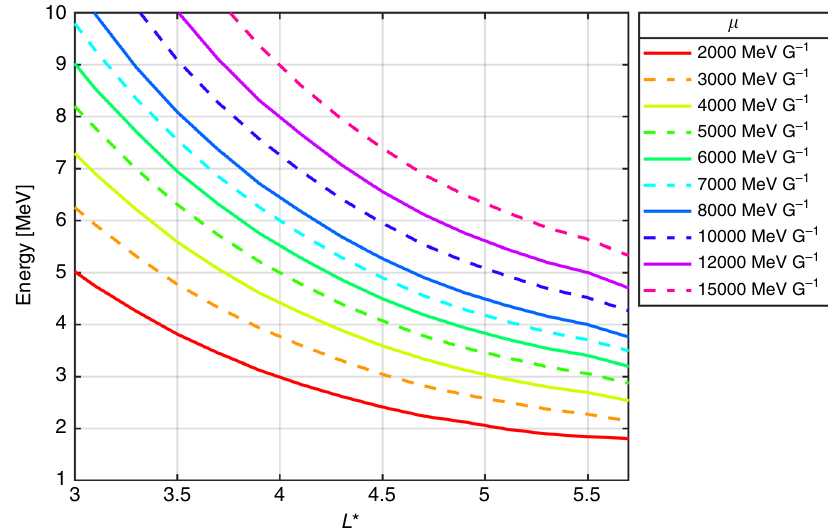
Fig. 2 The average electron energy, across L *, for various values of μ . Average energies corresponding to μ values between 2000 and 15,000 MeV G − 1 , for the 6 – 20 October 2012 period are shown. For all values of μ , K = 0.11 R E G 1/2 . The μ value has been calculated using the locally measured magnetic fi eld, while K and L * were calculated using TS07 27 .